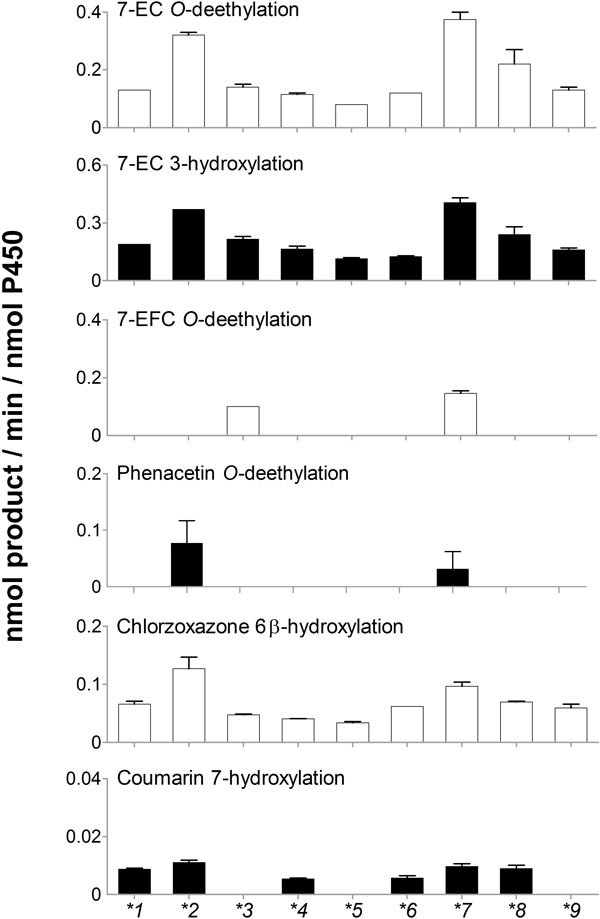
Catalytic promiscuity of natural variants of CYP102A1 towards human P450 substrates. Purified natural variants of CYP102A1 were characterized for human P450 enzyme activities using specific substrates: phenacetin O-deethylation for P450 1A2; 7-ethoxycoumarin (7-EC) O-deethylation for P450s 1A2, 2A6, and 2E1; 7-ethoxy-4-trifluoromethylcoumarin (7-EFC) O-deethylation for P450s 1A2 and 2B6; chlorzoxazone 6β-hydroxylation for P450 2E1; coumarin 7-hyroxylation for P450 2A6. Data are shown as the means ± SEM.